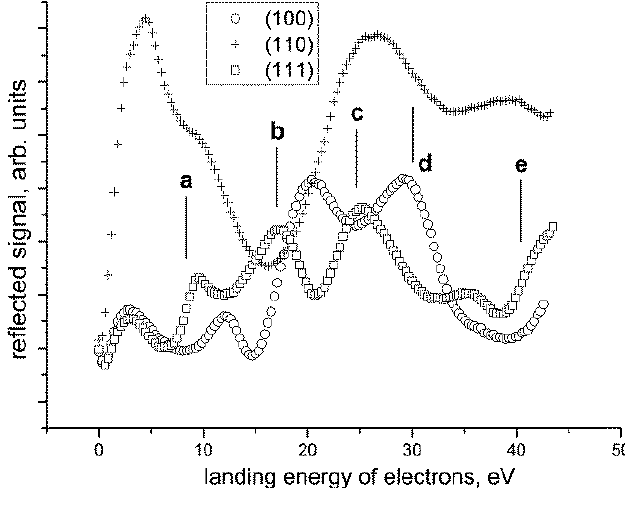
Figure 18. Reflectance vs. energy plots for three basic orientations of in-situ cleaned single crystals of aluminum. Five energy values, labeled a to e , refer to Figure